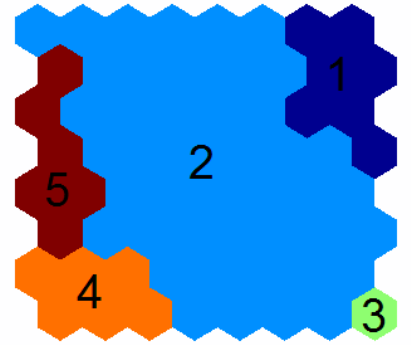
Figure 8. Hierarchical clustering of the map into five subclasses. The colors represent the subclass numbers: subclass 1 is dark blue, subclass 2 is blue, subclass 3 is green, subclass 4 is orange, and subclass 5 is